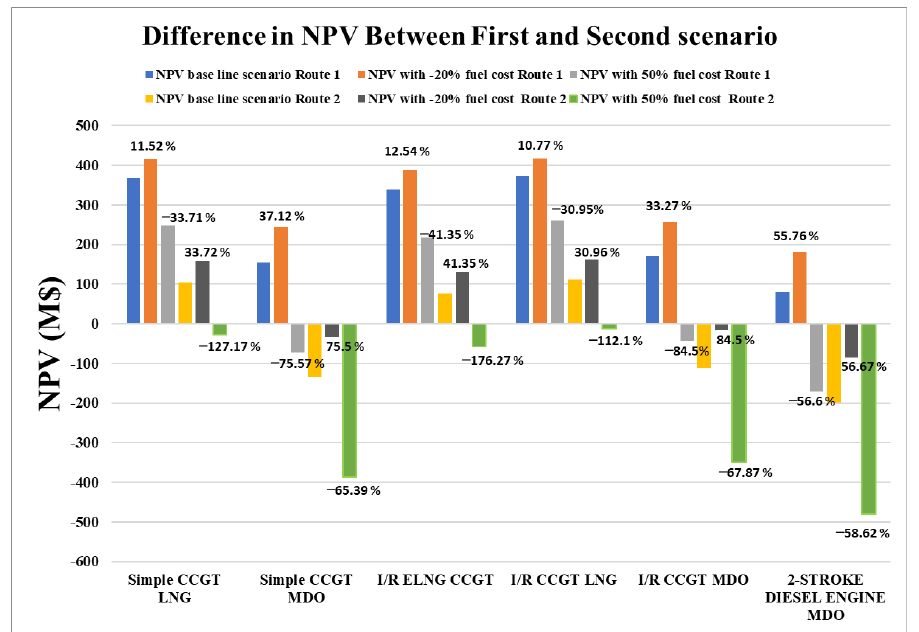
Figure 4 Difference in NPV between the first and second scenarios for Routes 1 and 2. Figure 4. Difference in NPV between the first and second scenarios for Routes 1 and